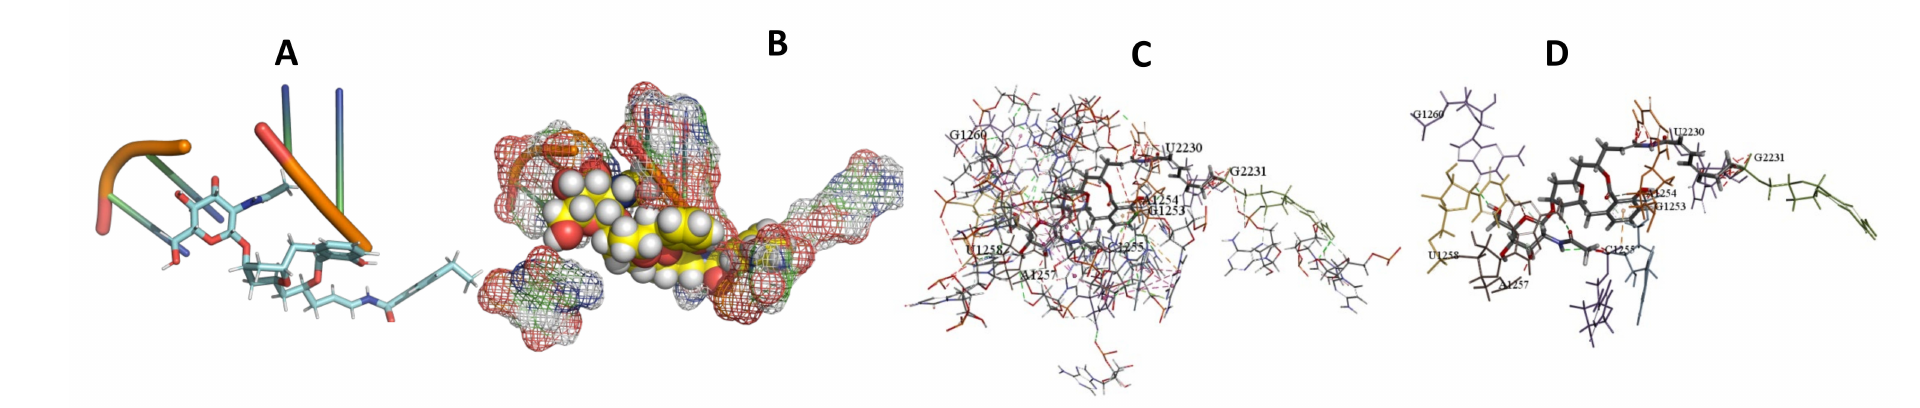
Figure 10. T. brucei + Apicuralen ( A ): Best binding pose and nucleotides involved. ( B ): Schematic binding pocket. ( C ): shows the Nucleotides component that re involved in binding. ( D ): Shows the main bonds involved between the compound and the nucleotide component.